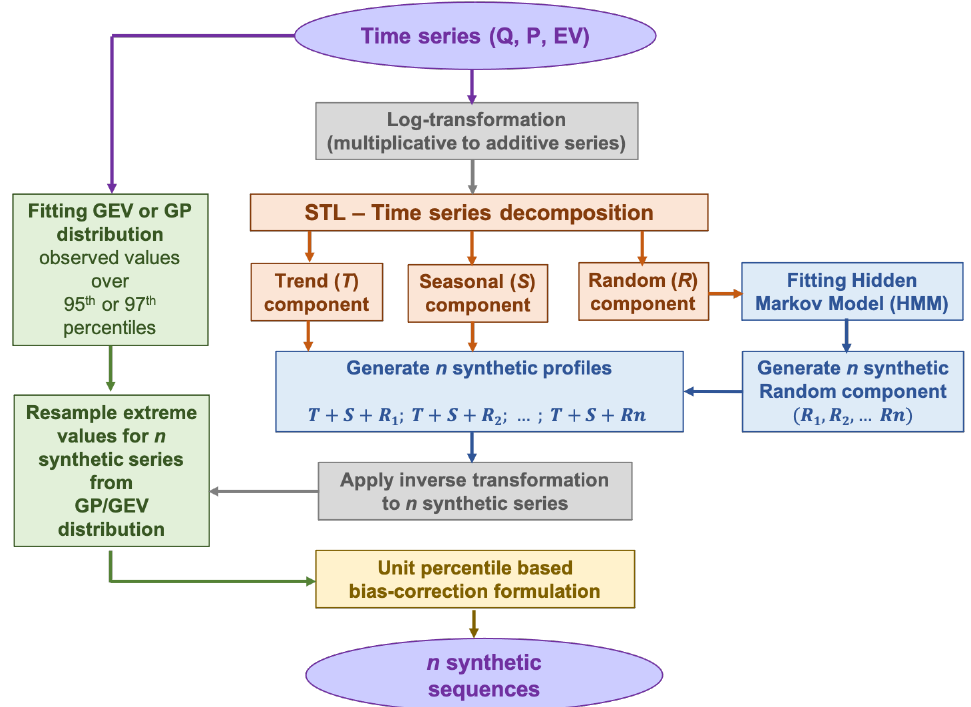
Figure 2. Work flow diagram of HMM_GP model, adapted from